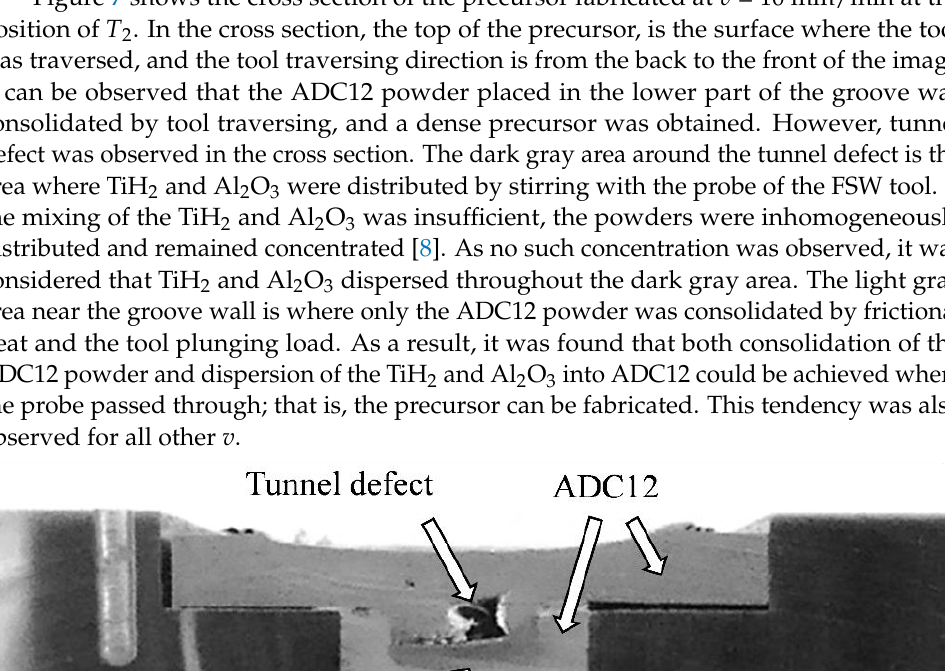
Figure 6. ( a – c ) Tool traversing behavior and ( d ) temperature history during precursor fabrication at v = 10 mm/min.